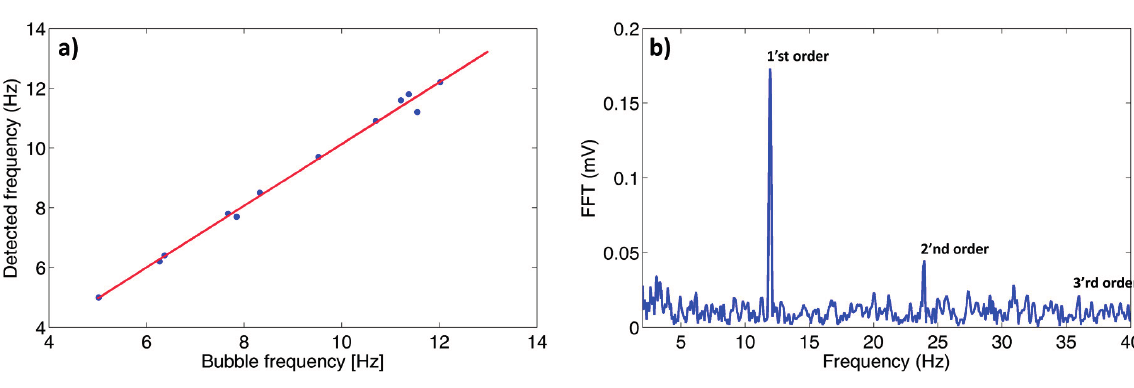
Figure 3. Measured Doppler frequency shift as a function of the bubble arrival rate as measured by a camera. The data is based on measuring the first order beat signal; ( b ) Fourier transform of a typical signal measured by the